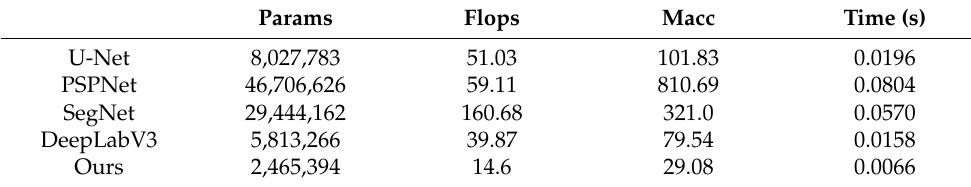
Table 4. Comparison of complexity requirements of different